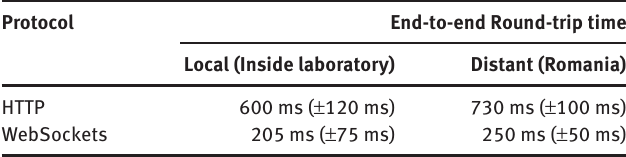
Table 2: End-To-End Round-Trip Time.